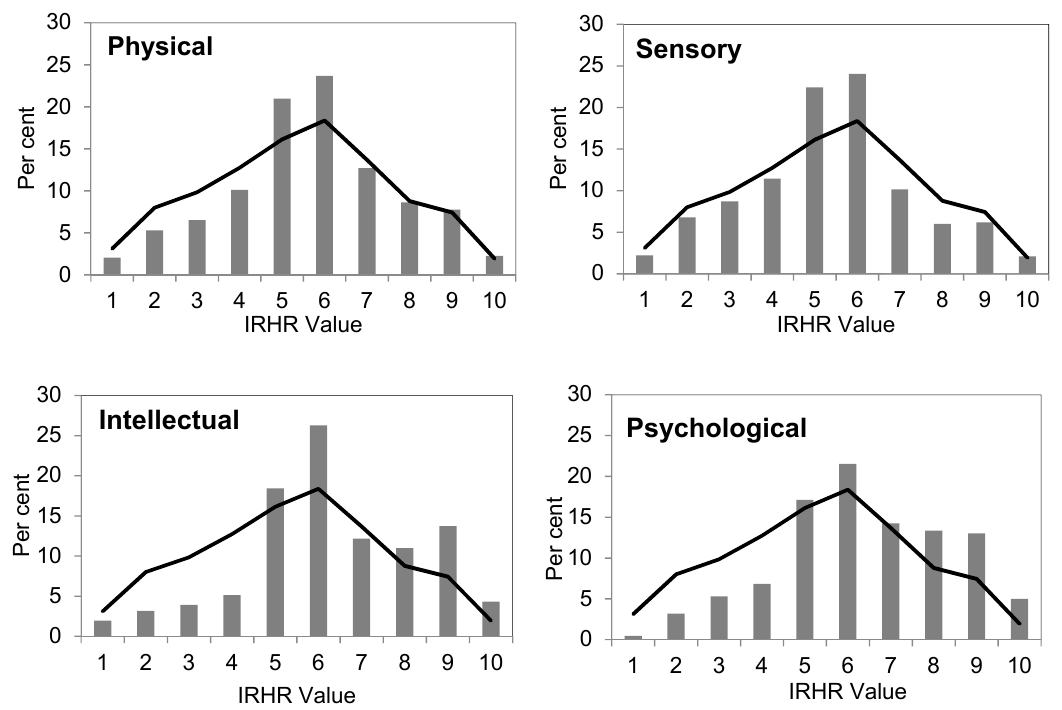
Figure 2. Index of relative homelessness risk for selected disability categories (data source: [25]), grey bars indicate disability and black line indicates no disability or long-term health condition.